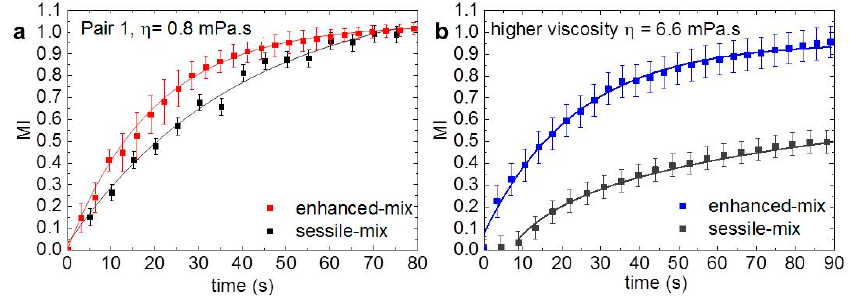
Figure 4. Mixing index (MI) change in time. Average curves of an actual flowrate of 50 µL/min for ( a ) pair 1 and ( b ) pair 2.